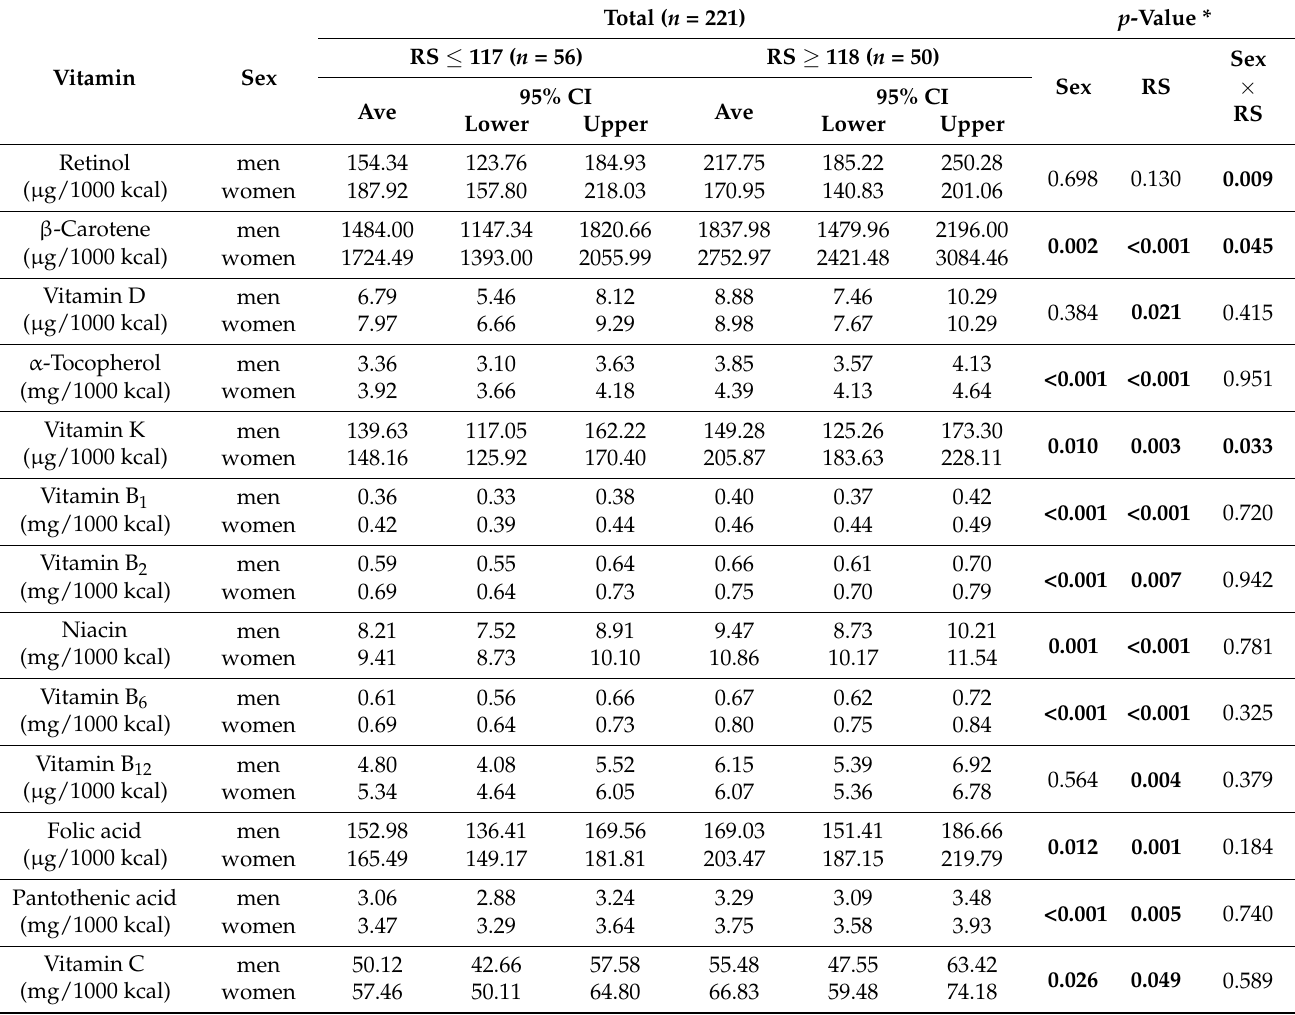
Table 3. Interactions between sex and the resilience scale (RS) according to vitamin